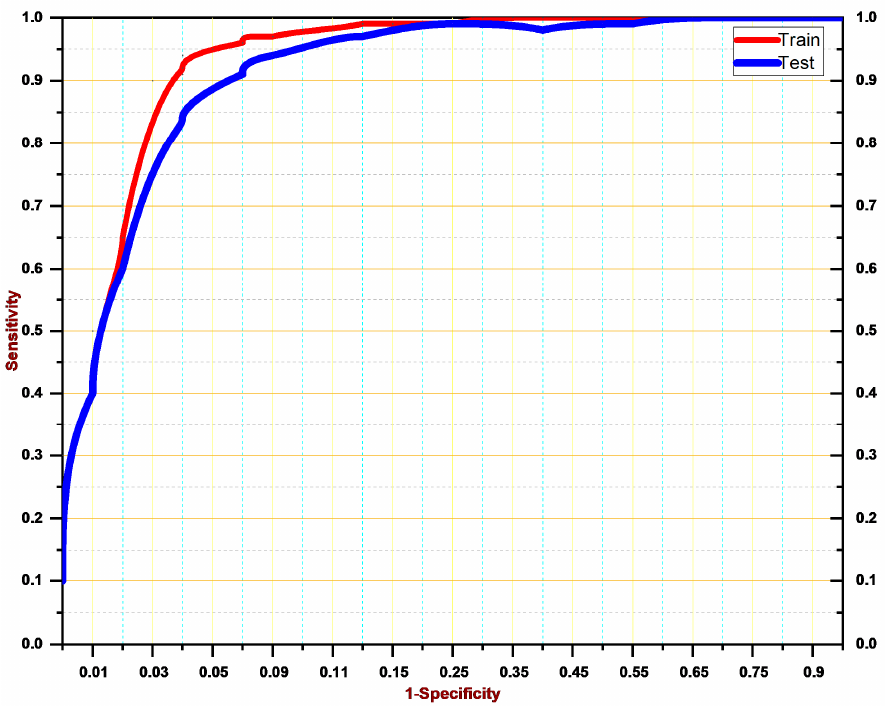
Figure 12. ROC curve for the proposed system.